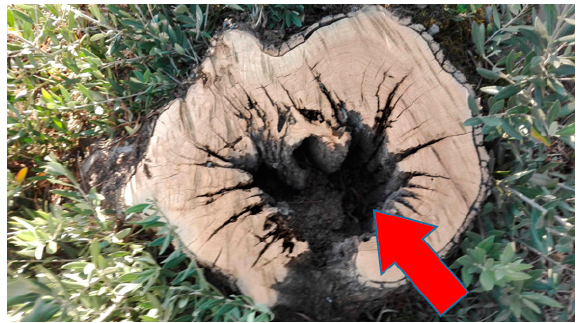
Figure 10. Felling the tree has shown the presence and size of the concealed damage (red arrow) detected by the IRT method.